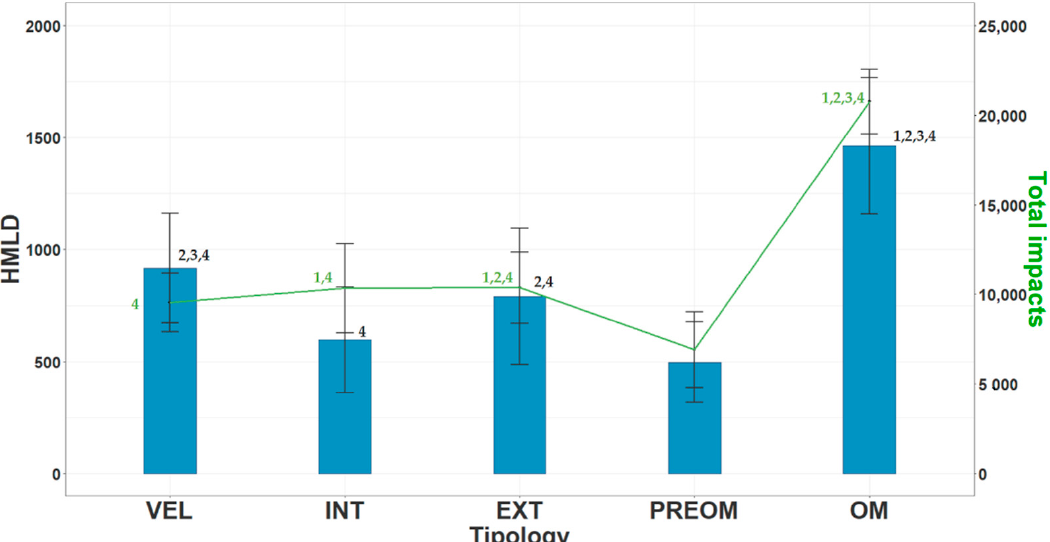
Figure 2. Means and deviations of the high metabolic load distance (HMLD, m, in blue) and total impacts (Total impacts, n, in green) of the players on the different training days. Note: VEL is velocity day, INT is intensity or strength day, EXT is extensity or endurance day, PREOM is previous day to match day, OM is official match day. Significant differences ( p < 0.05) are represented: 1 is higher than VEL, 2 is higher than INT, 3 is higher than EXT, and 4 is higher than PREOM. Table 2. Effect size of external load variables in different training and competition